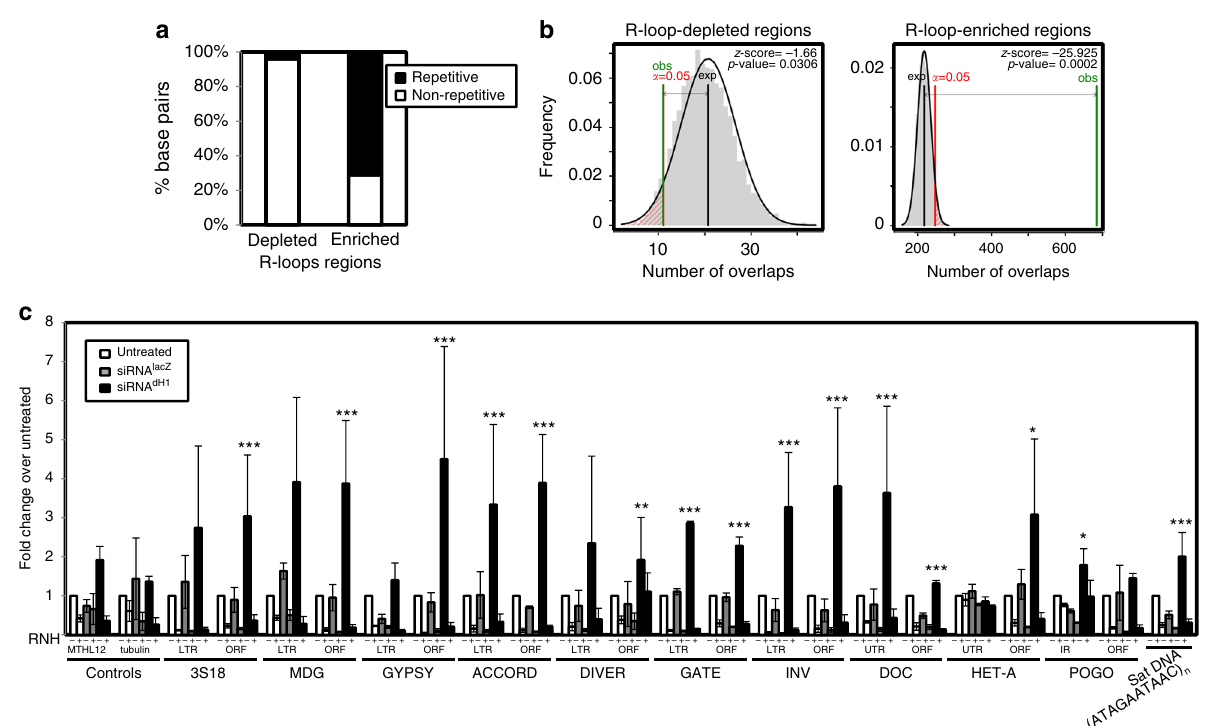
Fig. 5 R-loops induced by dH1 depletion accumulate in heterochromatin. a The proportion of base pairs (bp) matching to repetitive and non-repetitive elements, as determined by RepeatMasker analysis, are presented for regions showing speci fi c R-loops enrichment and depletion in dH1-depleted cells respect to control untreated cells. b Permutation experiments showing statistical signi fi cance of the enrichment in repeated DNA sequences of the regions showing speci fi c R-loops enrichment ( right ) and depletion ( left ) in dH1-depleted cells respect to control untreated cells. The frequency of the number of overlaps with repetitive DNA elements, as determined by the regioneR package using the UCSC dm3 RepeatMasker track (March 2017), is presented based on 5000 random permutations of the experimentally identi fi ed regions. The average expected number of overlaps ( black ) is compared with the observed number of overlaps ( green ). The α = 0.05 con fi dence interval is indicated ( red ). z -scores and permutation test p -values of the differences are also indicated. c DRIP-qPCR analyses at the indicated regions in siRNA dH1 cells, siRNA lacZ and untreated cells. Before immunoprecipitation samples were treated with bacterial RNH (+) or not ( − ) ( N = 2). For each position, the fold-change respect to the untreated condition at this position is presented. Error bars are s.e.m. The p -values of siRNA dH1 with respect to siRNA lacZ are indicated (no asterisk > 0.05, * < 0.05, ** < 0.01, *** < 0.005; two-tailed Student ’